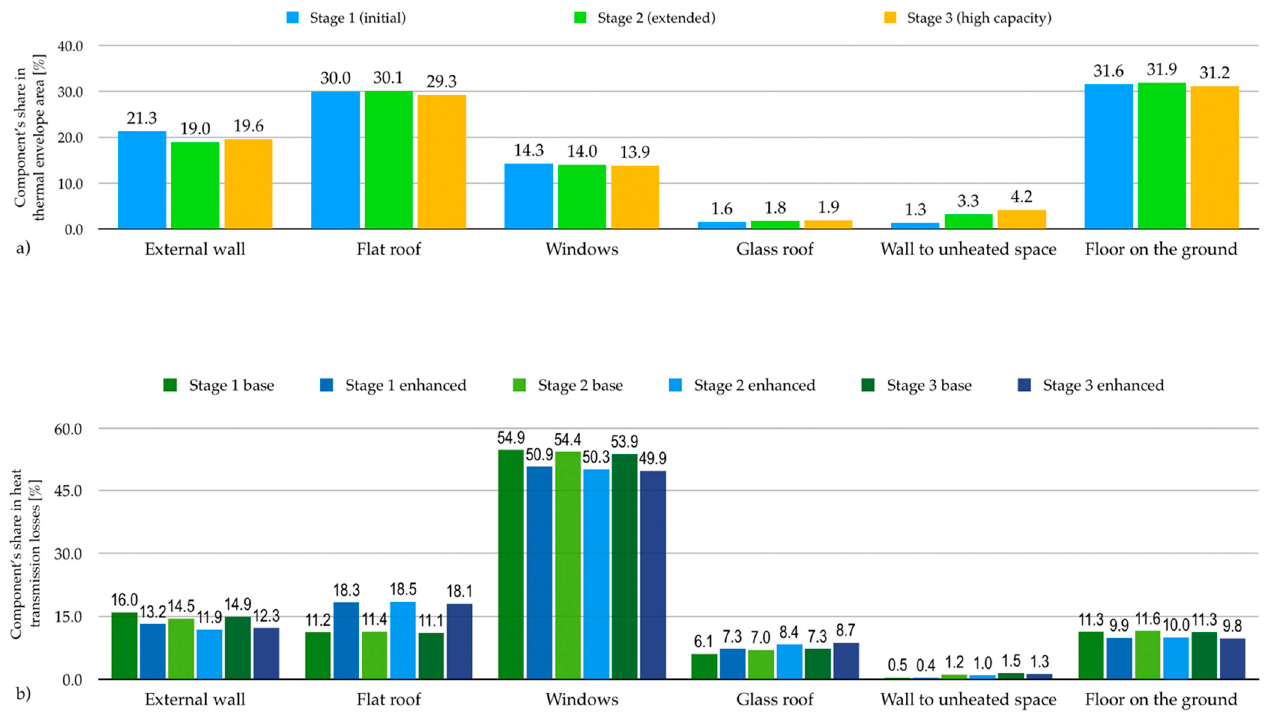
Figure 15. Distribution of thermal envelope components: ( a ) per surface area and ( b ) per contribution to heat transmission losses.